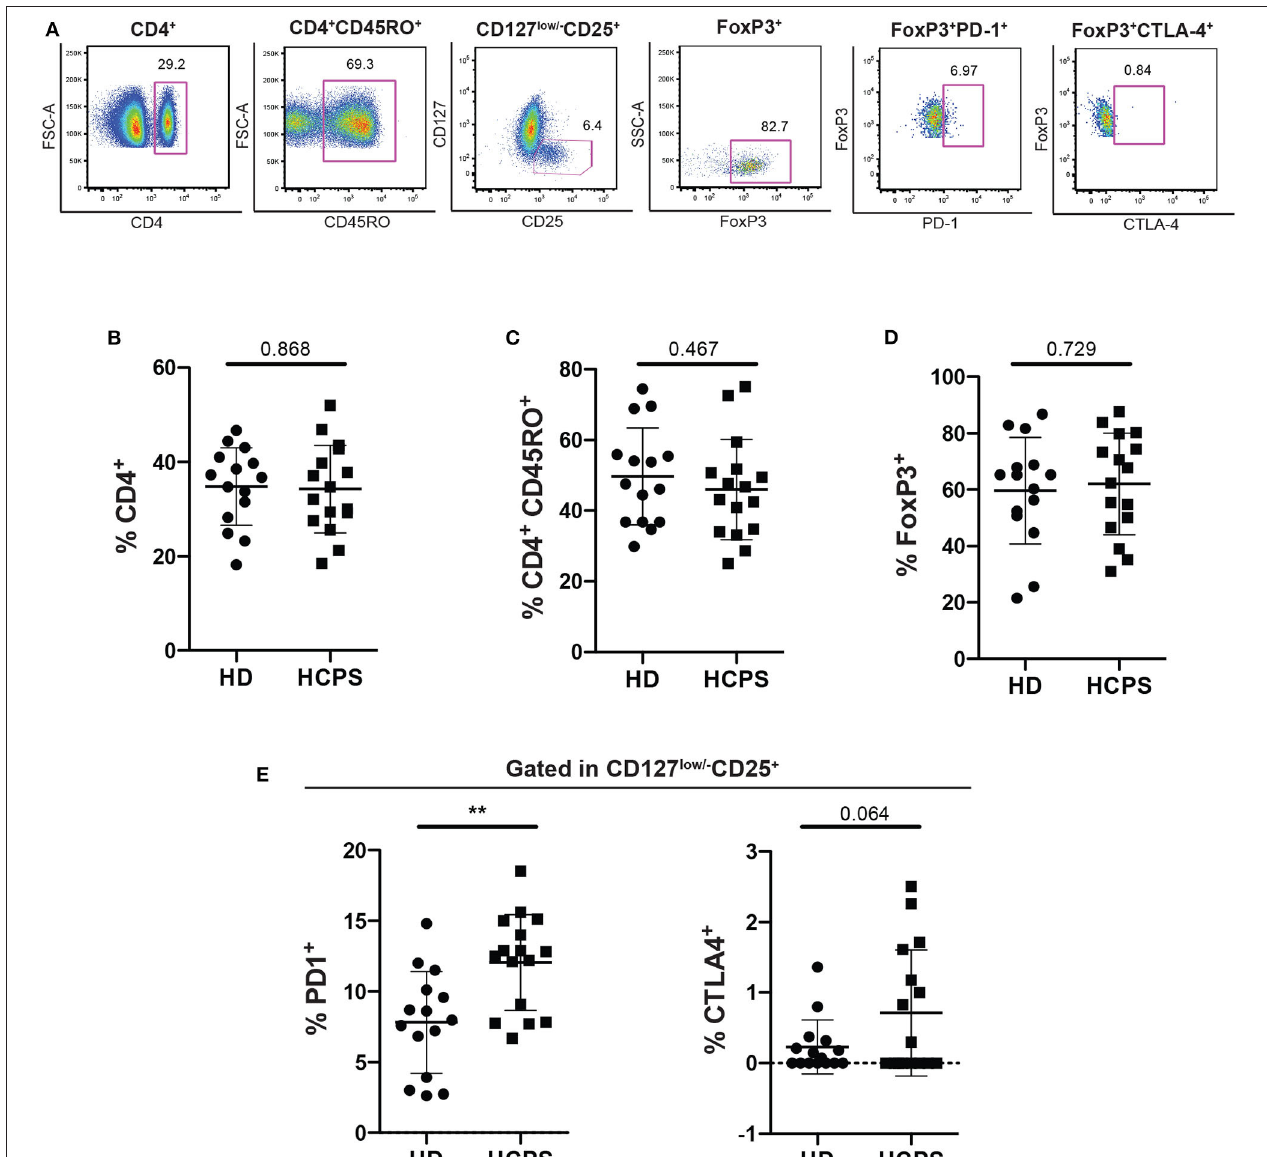
FIGURE 1 | Increase frequency of memory CD4 + Treg PD-1 + on HCPS survivors. (A) Gating strategy of a representative sample showing CD4 + , CD4 + CD45RO + , CD127 low / − CD25 + , CD127 low / − CD25 + FoxP3 + , memory Treg PD1 + , and memory Treg CTLA-4 + cells. (B) Frequency of total CD4 + T cells gated in live PBMC. (C) Frequency of memory CD4 + T cells CD4 + CD45RO + . (D) Frequency of memory CD4 Treg (CD4 + CD45RO + CD25 + CD127 low / − FoxP3 + ). (E) Frequency of memory Treg PD-1 + (left) and memory Treg CTLA-4 + (right). Data represented as dots (HD n = 15) and squares (HCPS n = 16), indicating the mean ± SD. ** P = 0.0021 by unpaired Student’s t -test.